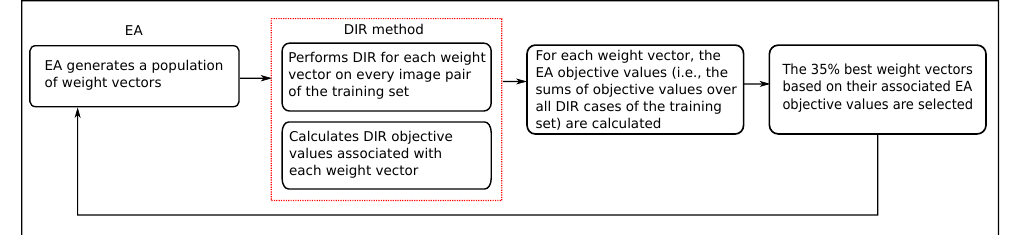
Figure 4. A flowchart of the proposed multi-objective evolutionary class solution learning approach. It contains a double optimization loop: in the inner loop (red dashed line), each DIR problem instance for a given weight vector is solved; in the outer loop (black solid line), the weight optimization problem is solved by the